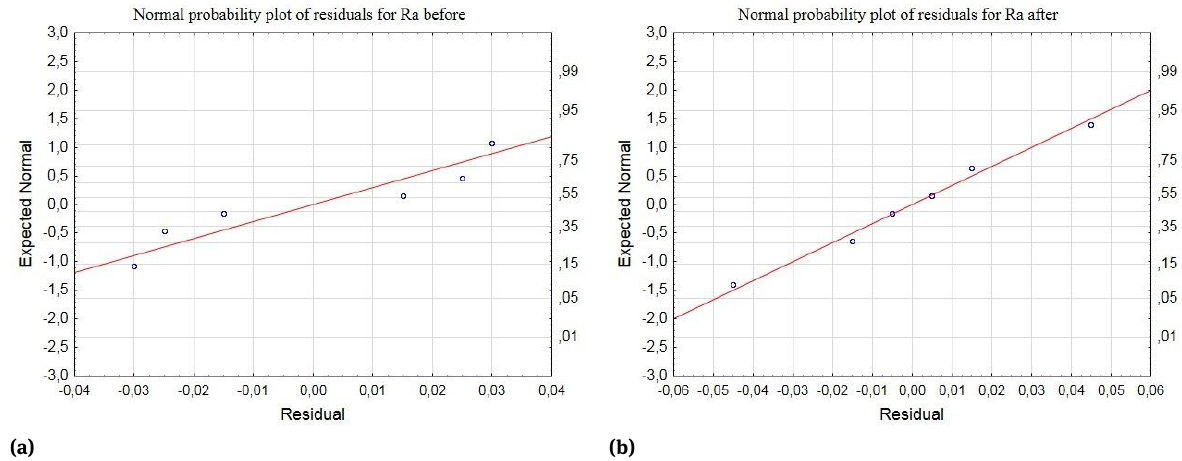
Figure 6: Graphs of the normal probability plot of residual for Ra surface roughness (a) before the tribological test, (b) after the tribological test